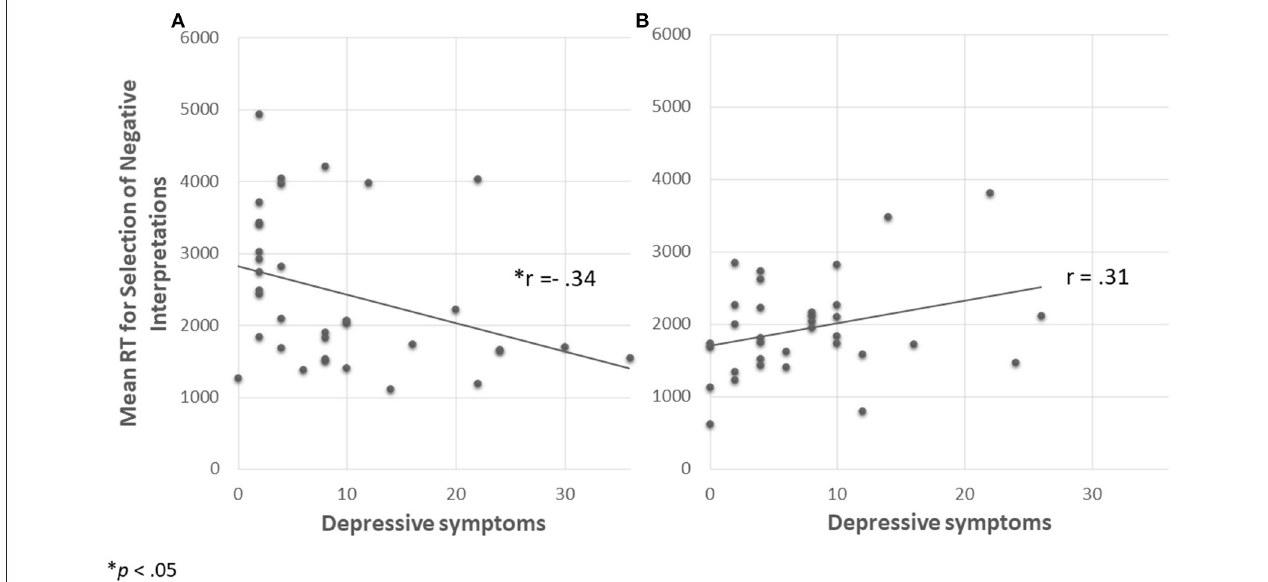
FIGURE 3 | Mean RTs for selection of negative interpretation predicted by depression symptoms in each social experience condition [ (A) ostracism, (B) overinclusion] Note that participants with higher depression symptoms selected negative interpretations faster in the ostracism than in the overinclusion